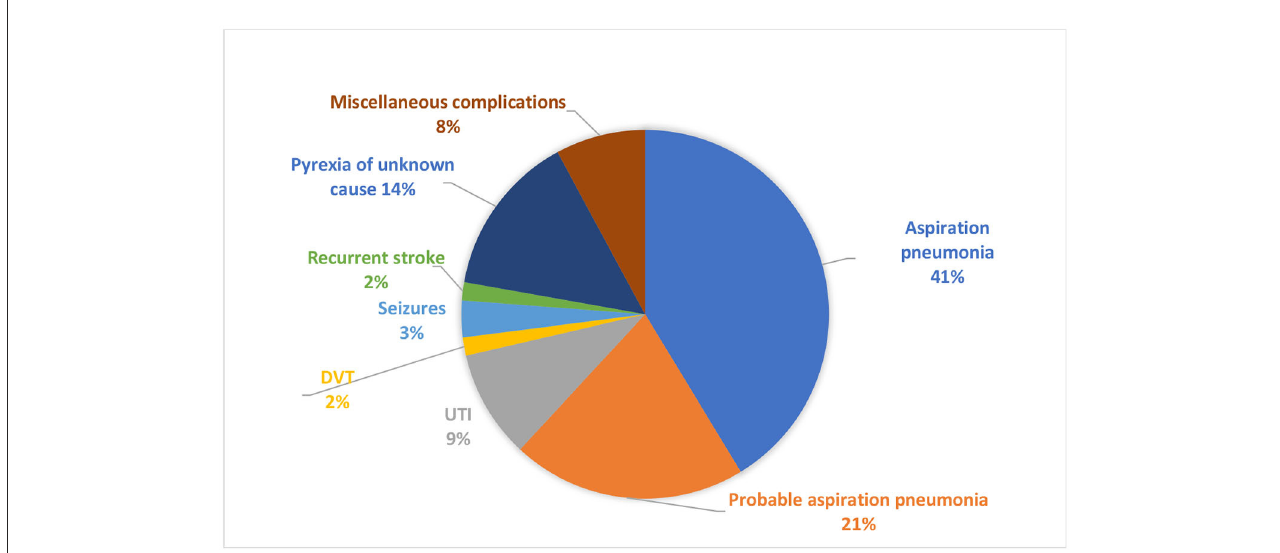
FIGURE2 Medical complications